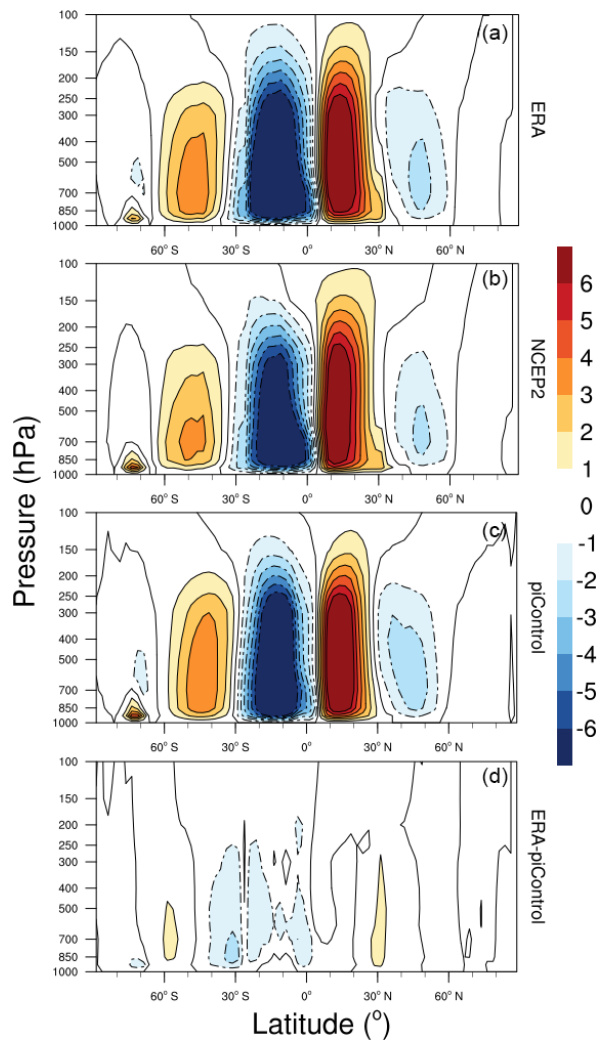
Figure 4. Hadley circulation in the ERA-Interim reanalysis (a) , NCEP2 reanalysis (b) , model ensemble mean under piControl (c) and the difference between ERA-Interim and piControl (d) . Color bar indicates the value of averaged meridional mass stream function (10 10 kgs − 1 ). Warm colors (positive values) indicate a clockwise rotation and cold colors (negative values) indicate an anticlockwise rotation.